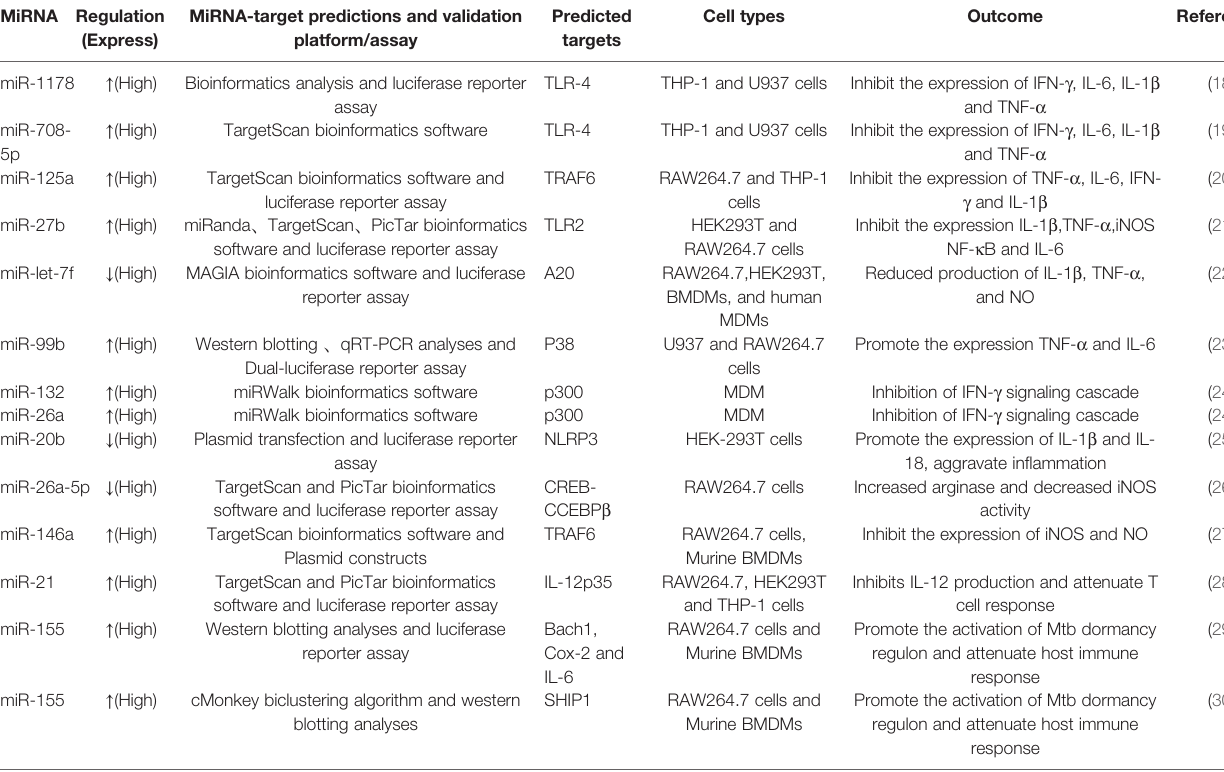
TABLE 1 | MiRNA-mediated regulation of signaling pathways during M. tuberculosis infection. MiRNA Regulation MiRNA-target predictions and validation (Express)